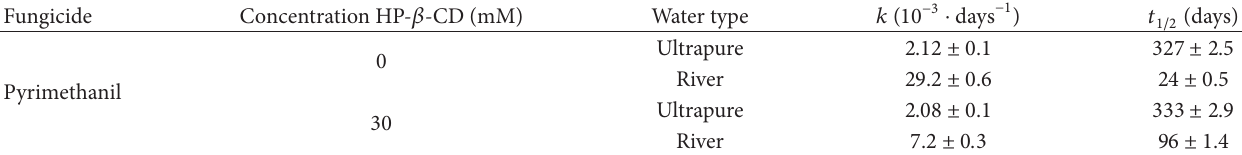
Table 2: Kinetic parameters of pyrimethanil photodegradation in different aqueous